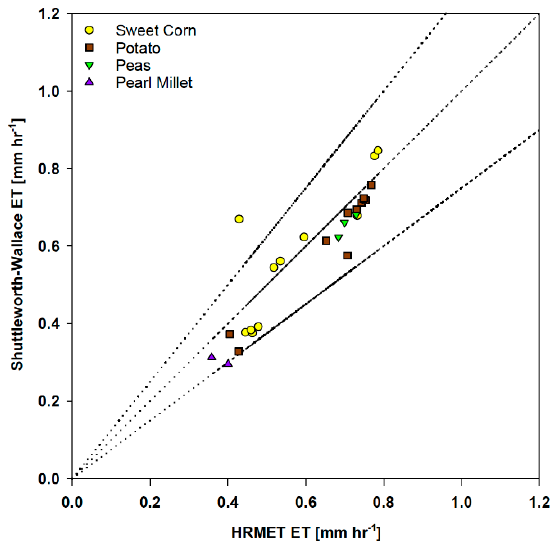
Figure 5. Comparison of HRMET and Shuttleworth–Wallace ET rates (mm hr − 1 ) for irrigated sweet corn, potatoes, peas, and pearl millet cropping systems. The dashed lines represent a 1:1 fit ± 25% error.